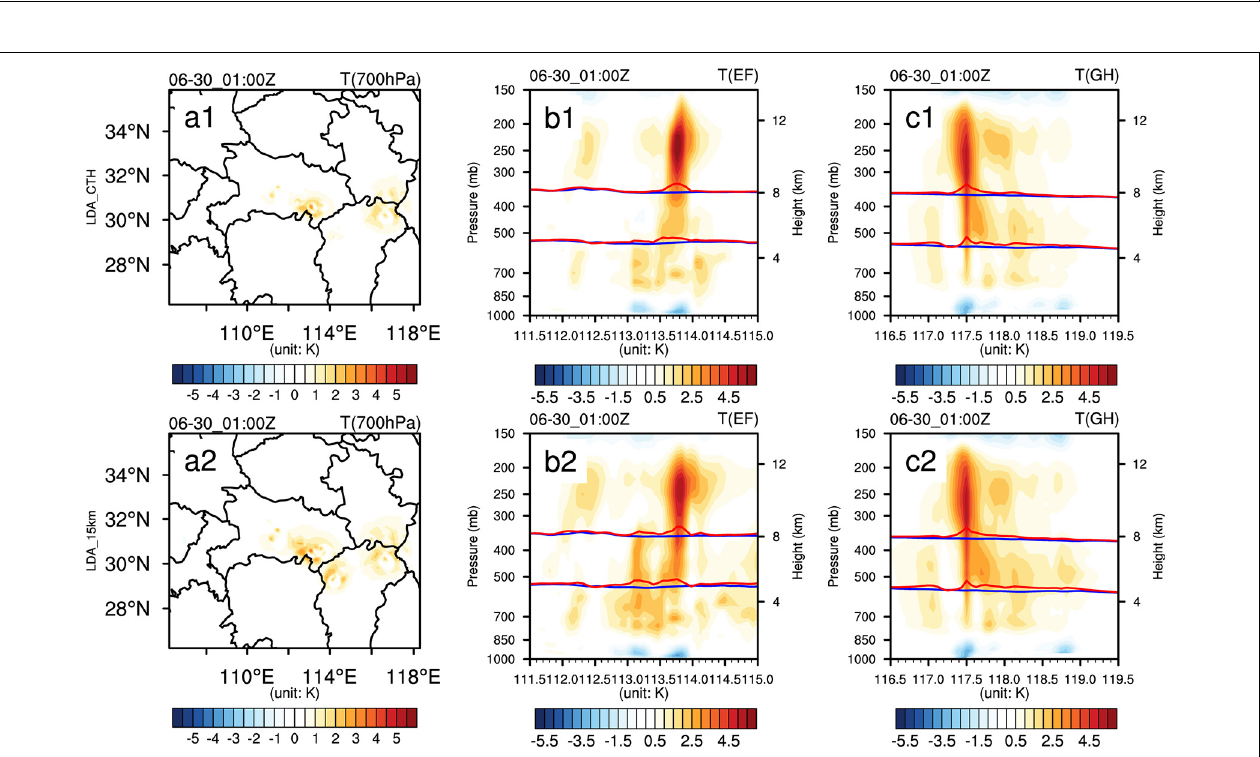
FIGURE 9 | The temperature difference between LDA_CTH and CTL (a1,b1,c1) and between LDA_15km and CTL (a1,b2,c2) at 700 hPa for 0100 UTC on 30 June 2018. The locations of the vertical cross sections are denoted with black lines EF and GH in Figure 8 (a1) . The second column shows the cross sections along line EF, and the third column shows the cross section along line GH. The red lines ( b1,c1 for LDA_CTH, b2,c2 for LDA_15km) are the 0 and − 20 ◦ C isothermal levels, and the blue lines are those for CTL.